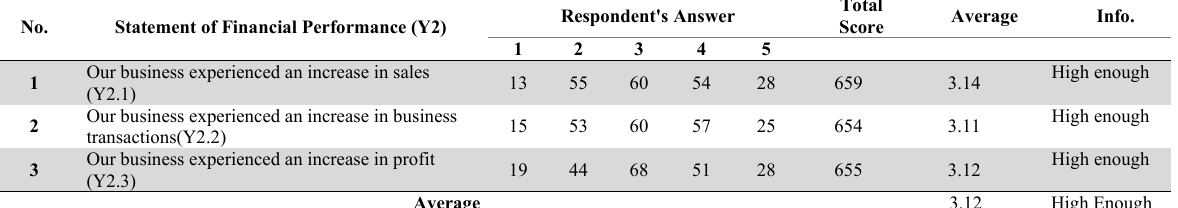
Description of Respondents' Answers Regarding the Assessment of Financial Performance Variables